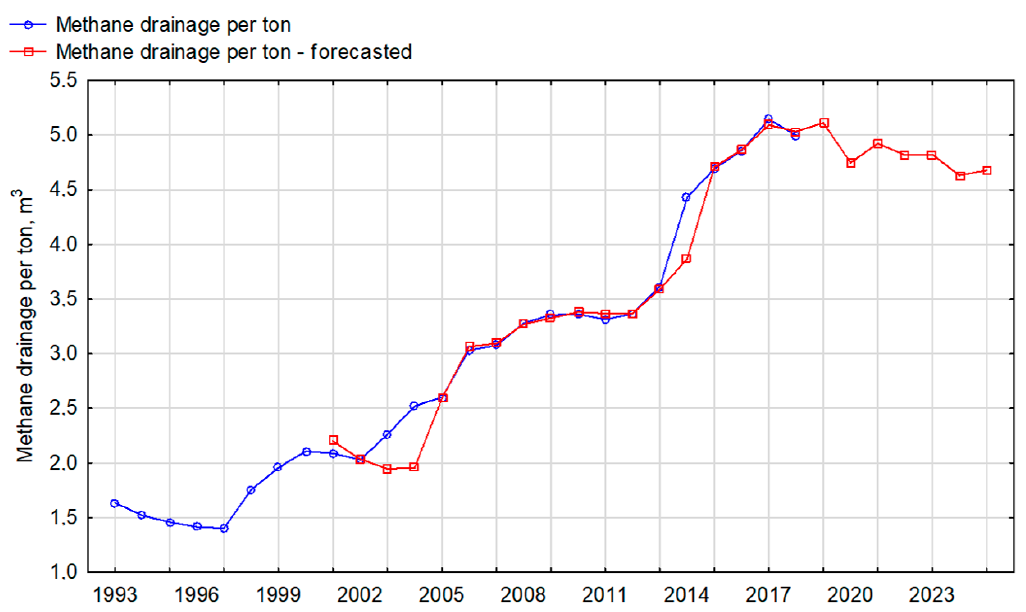
Figure 17. Actual and predicted amount of methane drainage per ton of extracted coal.